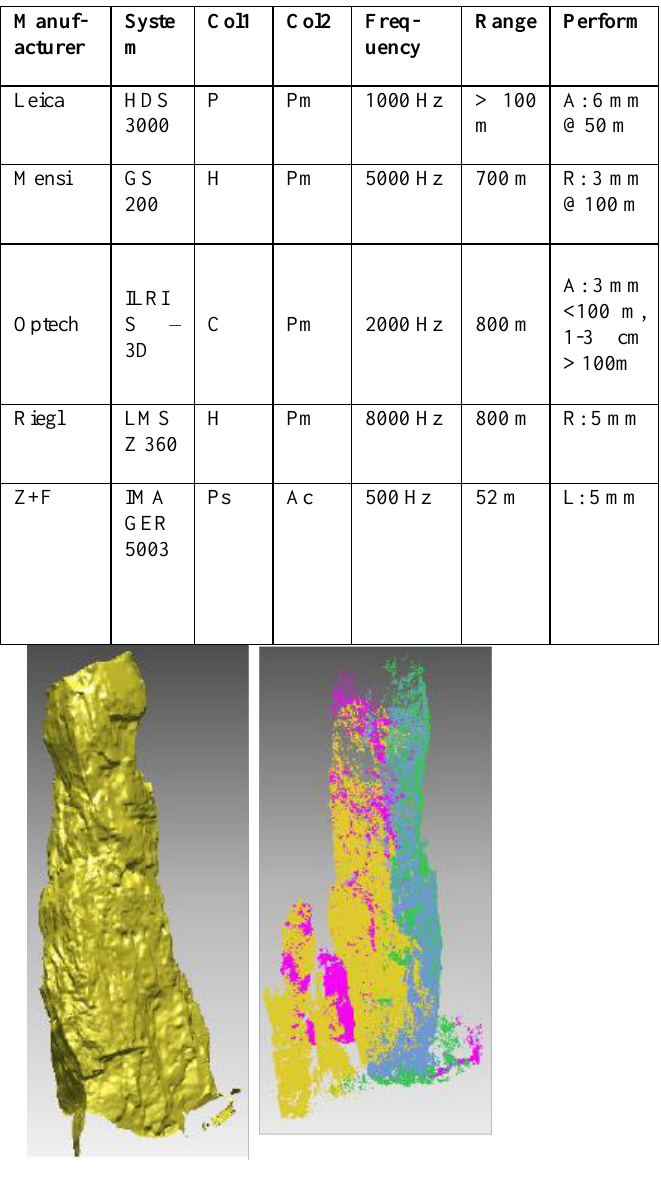
Figure 2. The Saint Jacques tower – Alléves – France – Model after the alignment process (left) and after the 3D modelling process (right) (Source: Bornaz & Rinaudo) Several researchers proposed different methods to extract 3D models from TLS data. A detailed description of their work is presented in this section. The research work presented by (Pu, 2008) shows a new approach which generates building façade outlines from TLS points clouds automatically. This research